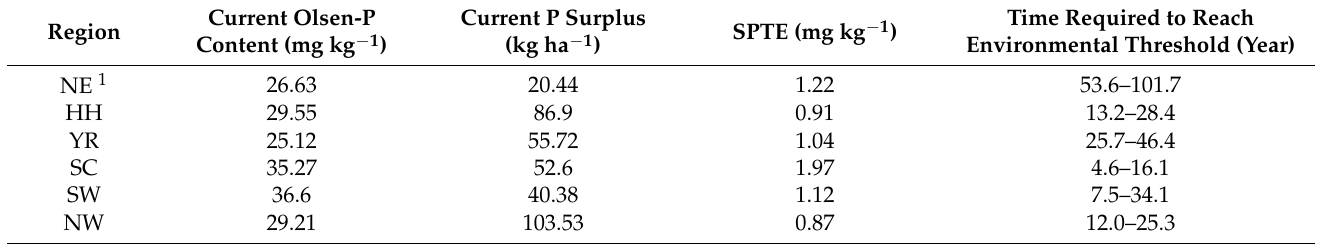
Table A3. A forecast of the time different Chinese regions will reach the environmental P threshold based on SPTE.